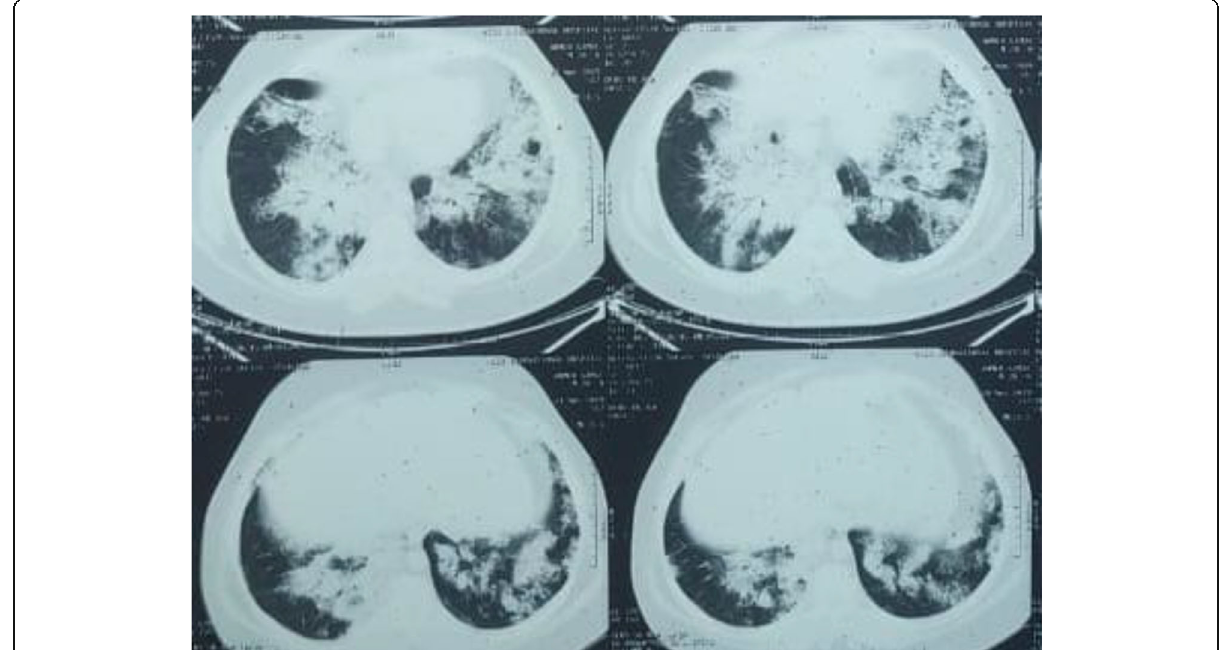
Fig. 4 High-resolution chest CT after 3 months of treatment with melphalan and